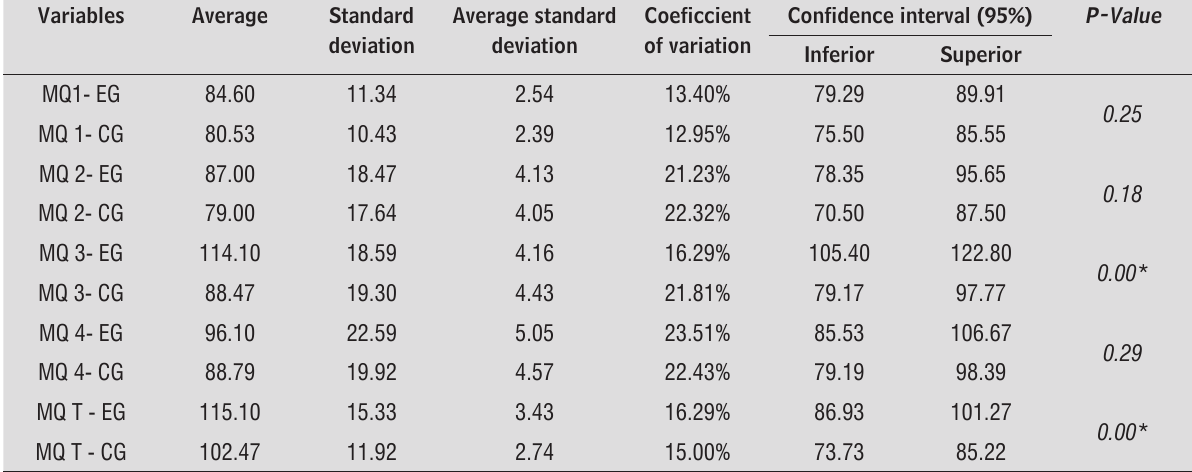
Average standard Coeficcient Confidence interval (95 % ) P-Value deviation deviation of variation Inferior